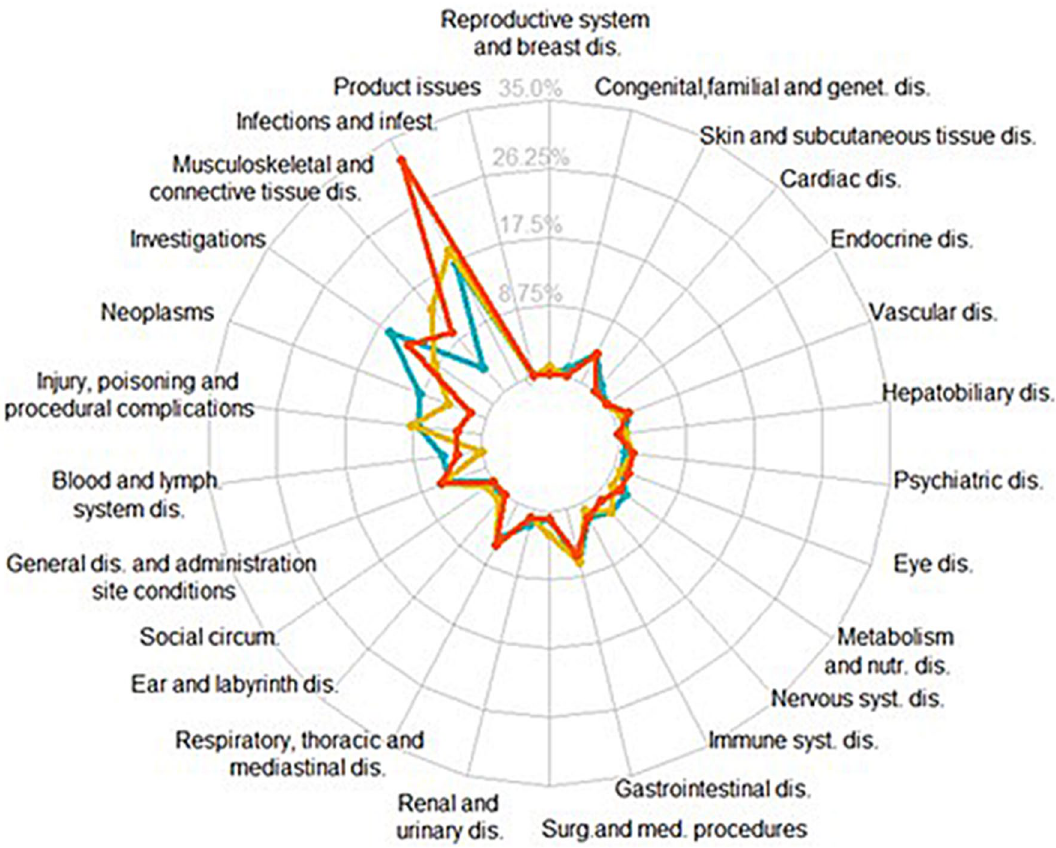
Figure 1. Proportion of Preferred Terms (MedDRA) with positive IC025 related to each JAK inhibitor according to the 27 different System Organ Classes. “Pregancy, puerperium and perinatal conditions” is not represented here because of no positive IC025 observed for any of the three drugs. Yellow curve represents tofacitinib, orange baricitinib and blue ruxolitinib. MedDRA: Medical Dictionary for Regulatory Activities; IC 025 : lower limit of the 95% credibility interval of the information component. A positive IC 025 is the statistical threshold used in